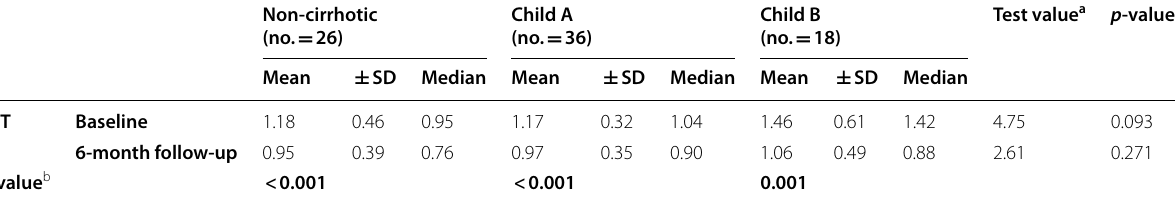
p 0.05 is considered statistically significant; p 0.01 is considered highly statistically significant. a Kruskal-Wallis test. b Wilcoxon signed-rank test. SD Standard ≤ ≤ deviation, IMT Intima-media thickness. IMT at baseline and 6-month follow-up after initiation of anti-HCV therapy and the presence of cirrhosis revealed that there was no significant difference between cirrhotic (neither child A nor B) and non-cirrhotic patients as regards carotid IMT at baseline and after 6-month follow-up. Meanwhile, there was significant decrease in carotid IMT at baseline compared to after 6-month follow-up in the three groups